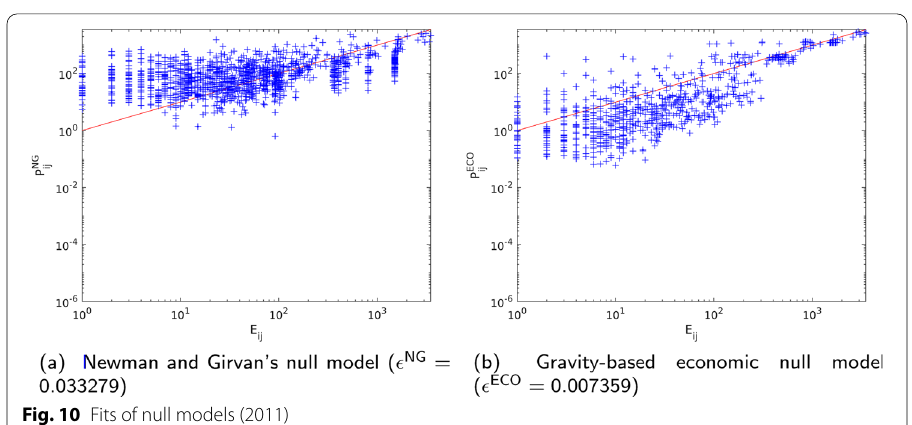
Fig. 10 Fits of null models